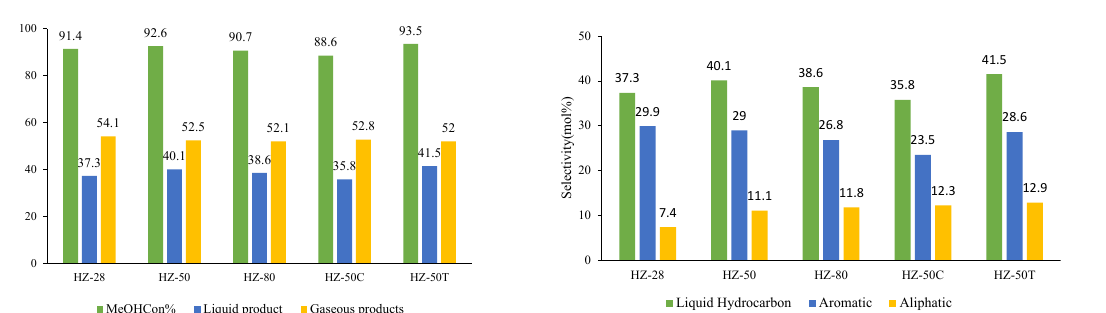
Fig.8. Selectivity of BTX products in HZ-28, HZ-50, HZ-80, HZ-50C, HZ-50T samples for P = 1atm, T = 400ºC, WHSV